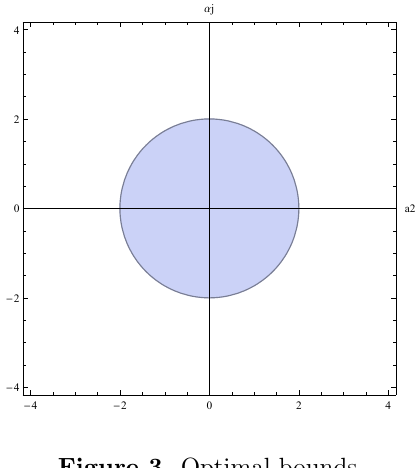
Figure 3 . Optimal